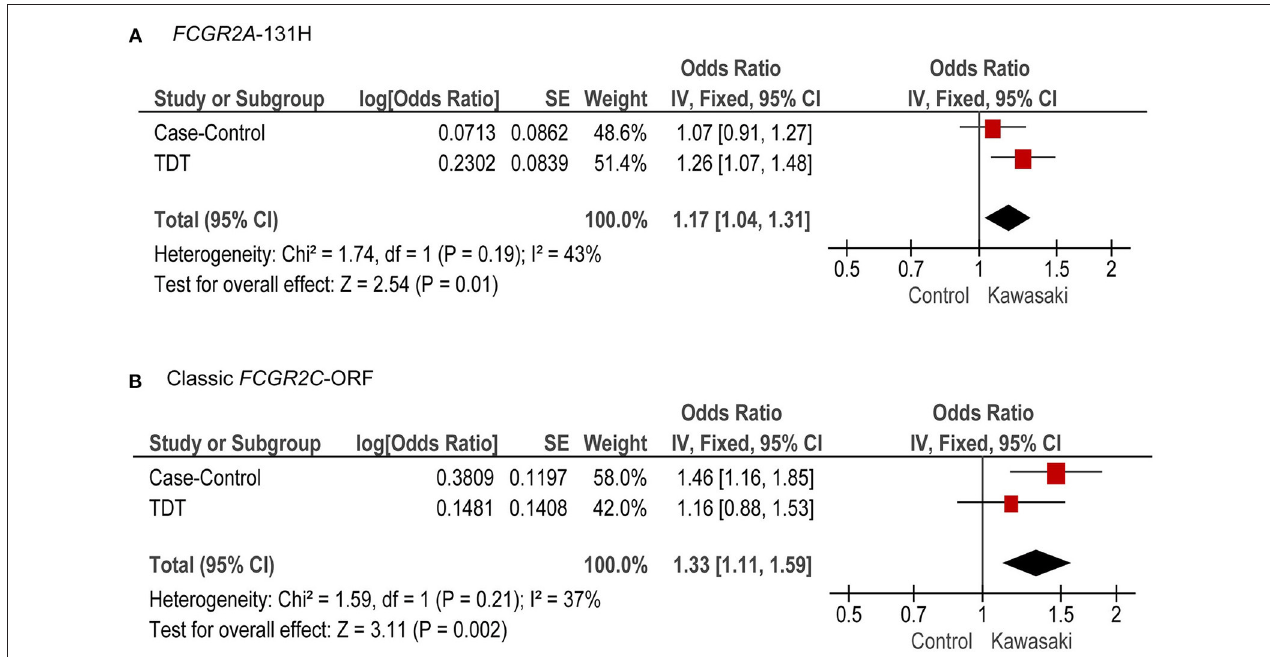
FIGURE 4 | Meta-analysis of case-control and TDT for FCGR2A -131H and the classic FCGR2C -ORF haplotype. Combined OR (95% CI) and P -values from the case-control study and TDT analysis, for FCGR2A -131H (A) and classic FCGR2C -ORF (B) . The 2B.2 variant in FCGR2C was omitted from the